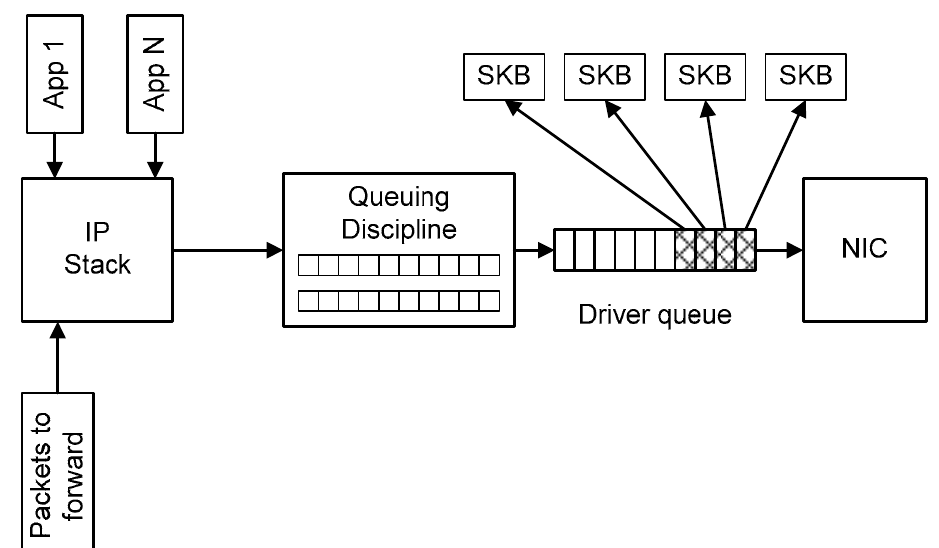
Figure 13. A simplified high-level overview of the queues on the transmit path of the Linux OS network stack.